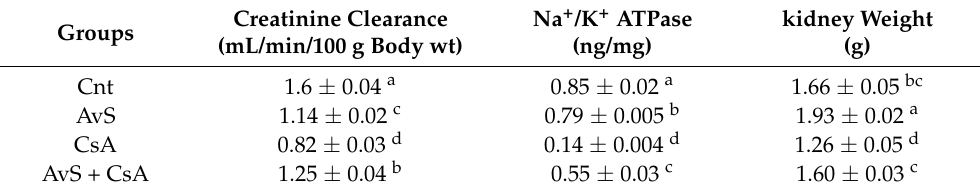
Table 7. Effects of avocado seed powder on creatinine clearance, Na + /K + ATPase, and kidney weight. Groups